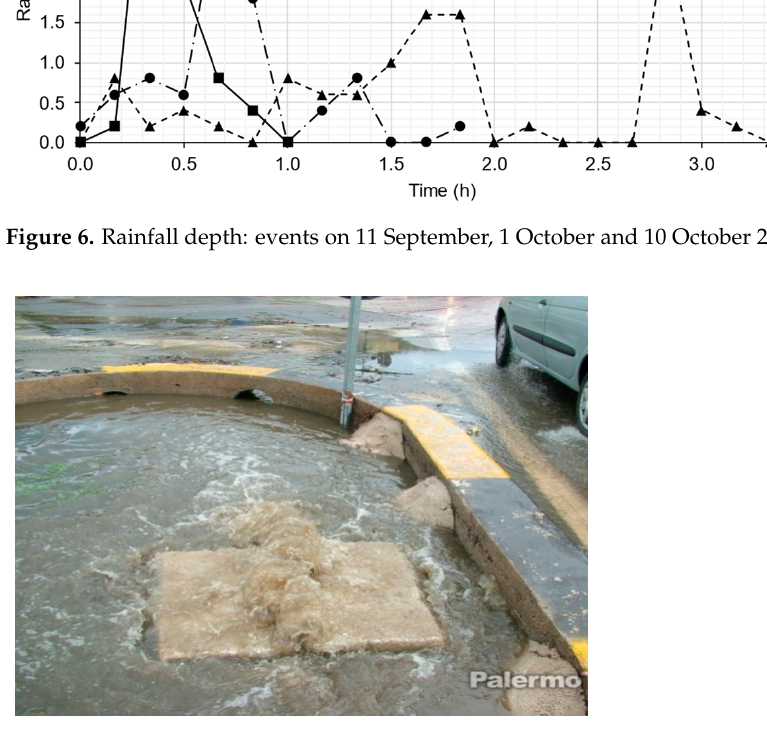
Figure 7. Manhole overflow at Piazza Castelforte. Source: web (www.palermotoday.it accessed on 27 October Figure 6. Rainfall depth: events on 11 September, 1 October and 10 October 2021.